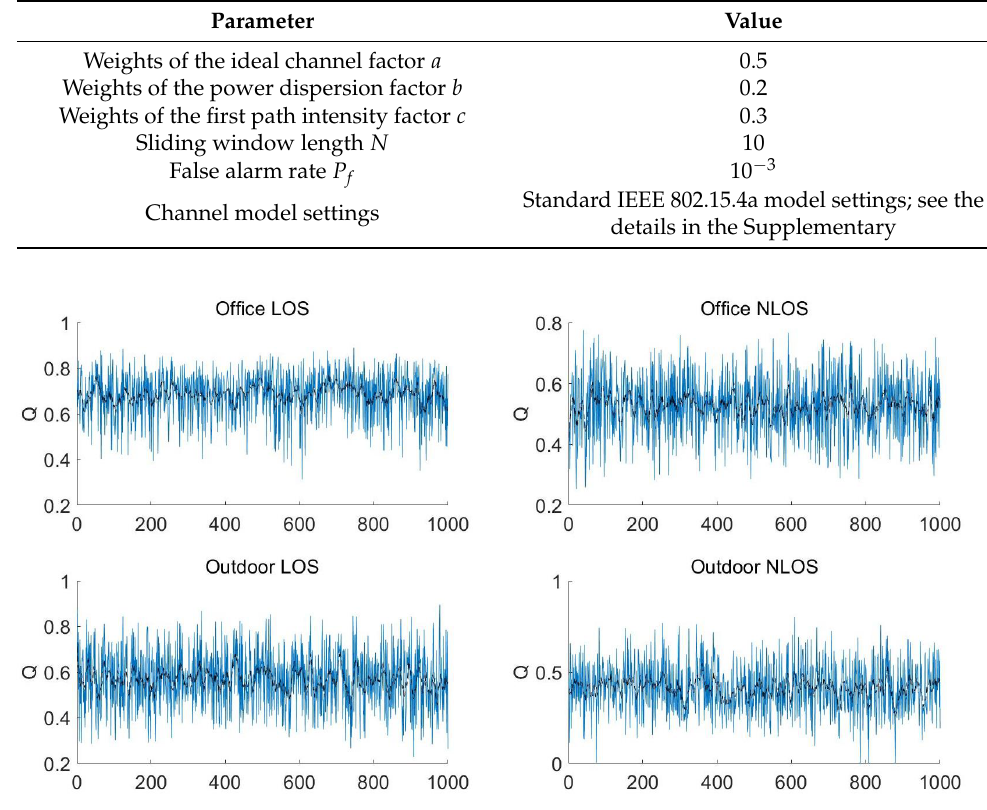
Figure 6. Result of the